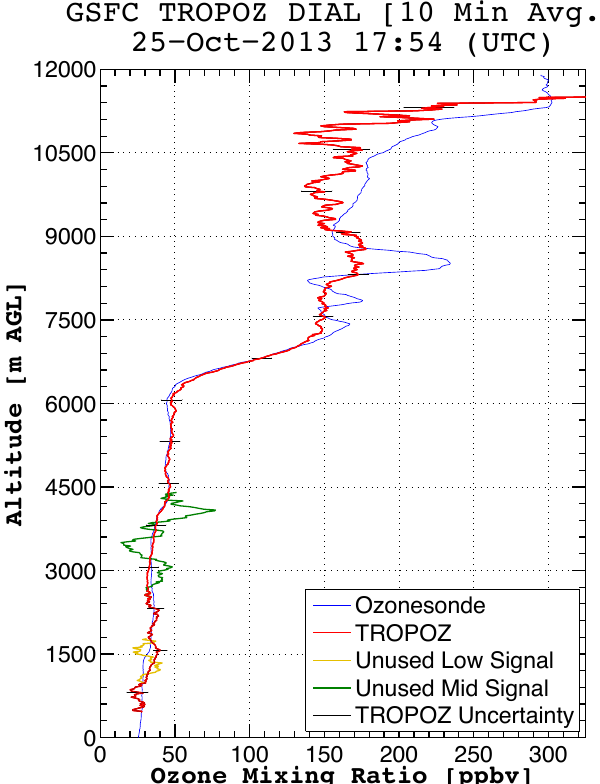
Figure 5. The profile comparison for the GSFC TROPOZ DIAL re- trieval (10min resolution) and the ozonesonde launch at 17:54UTC on 25 October 2013 at Beltsville, MD. (Source: Howard University Beltsville Center for Climate Systems